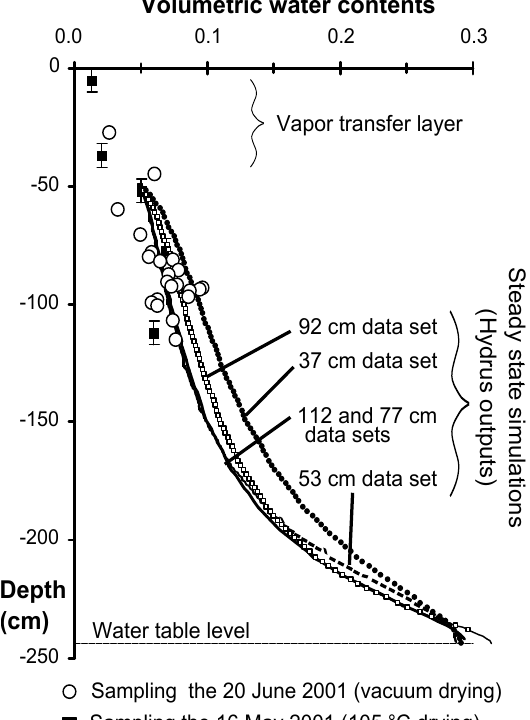
Fig. 2. Soil volumetric water contents in the sampled pit, on 16 May 2001 and 20 June 2001. Steady state Hydrus 1D water content profiles with the five different sets of van Genuchten hydrodynamic parameters. Because water contents were very low in the upper part of the profile (depths < 50cm), significant vapor transfer was suspected. Consequently, the top layer of the profile was not con- sidered in the simulation. Estimated accuracy was 0.5cm in level and 0.5% in water